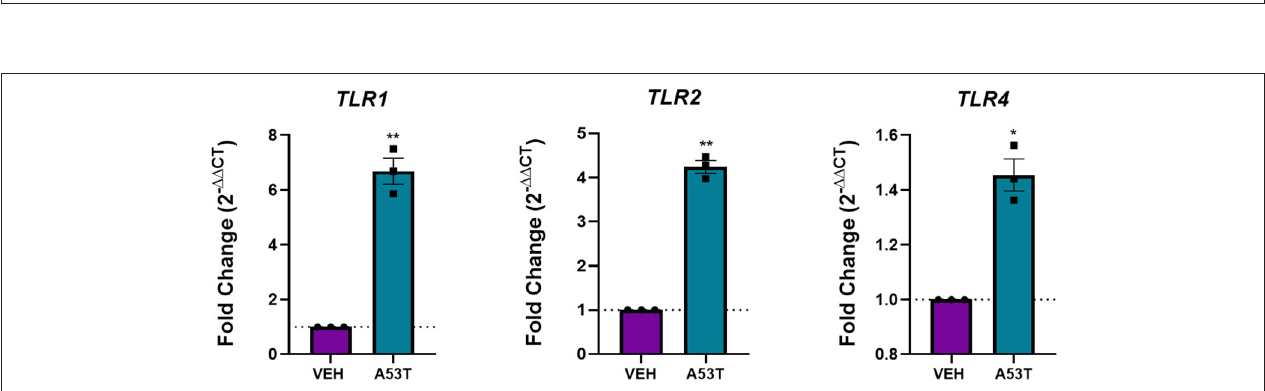
FIGURE 3 | TLRs are upregulated following A53T treatment of microglia. Microglia were treated with 1 µ g/mL misfolded A53T or vehicle (VEH) for 24h and changes in gene expression for TLR 1, 2, and 4 were evaluated using qRT-PCR. Microglia stimulated with misfolded A53T displayed increased levels of TLR1, TLR2 , and TLR4 mRNA expression compared to vehicle, ( n = 3 wells/treatment). Values are reported as mean ± SEM, using an unpaired Student’s t -test; ** P ≤ 0.01 and * P ≤